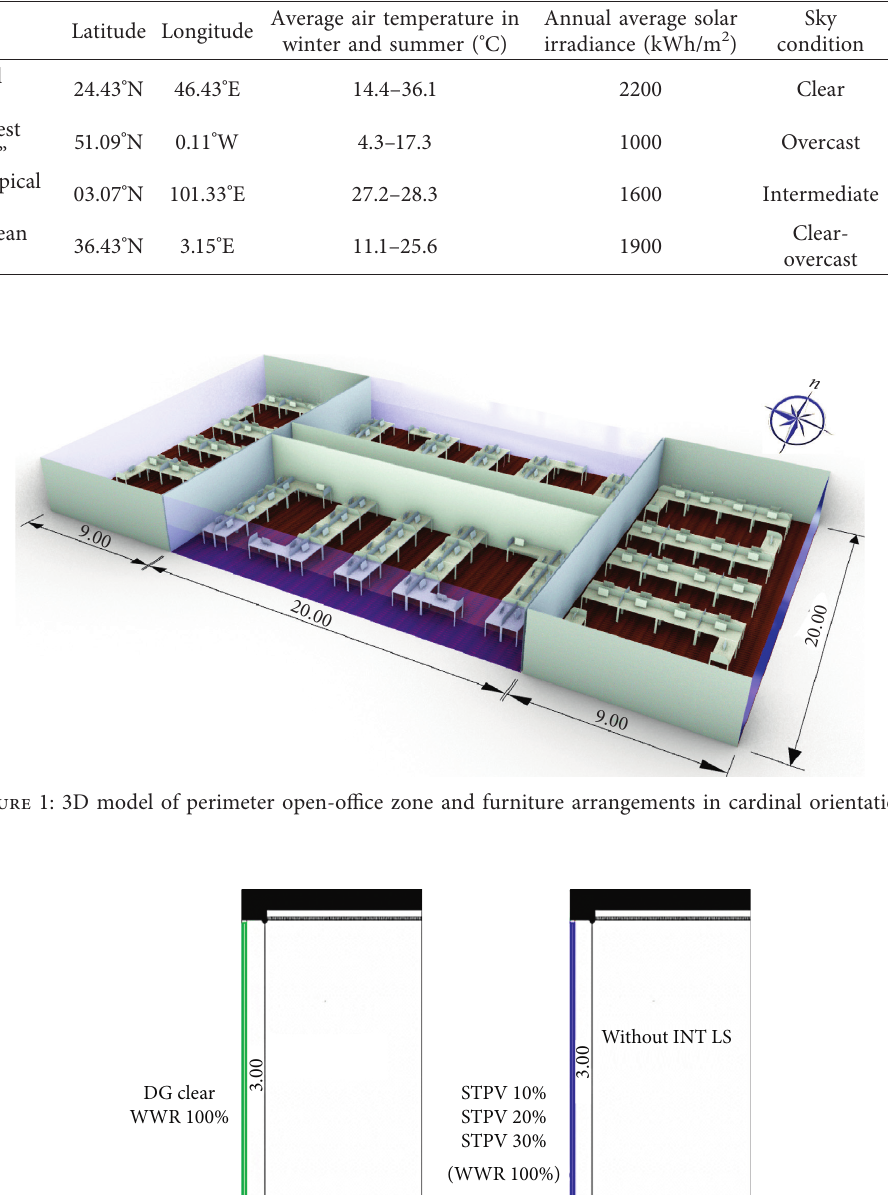
DG clear WWR 100%